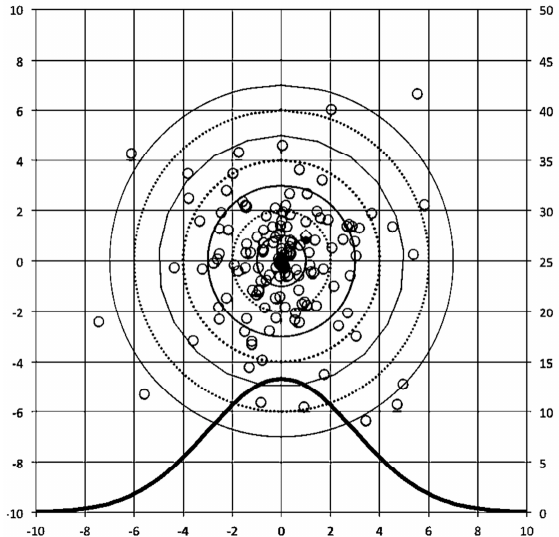
Figure 2. The normal distribution of bullet strikes on a target. Target practice shooting serves as an example of the assumptions of linear statistics, particularly the natural variation of a normal distribution purported to occur during repeated trials (figure—center). Normal distributions illustrate the central limit theorem, or the frequentist view of variability of events that assumes that the sum of numerous independent influences will have a normal or upside down ‘U’-shaped distribution (figure—bottom).